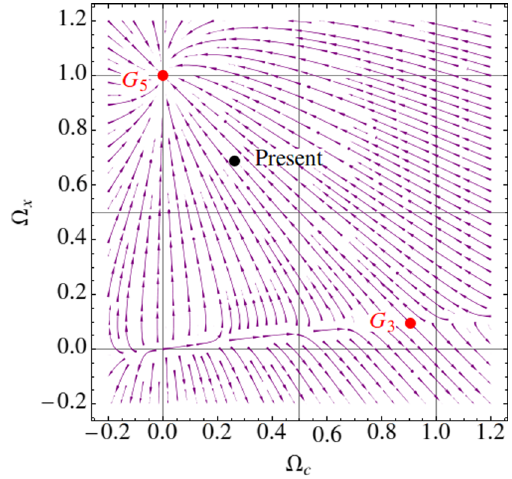
Fig. 7 Projected phase plots for model Γ 2 c with α = 0 .